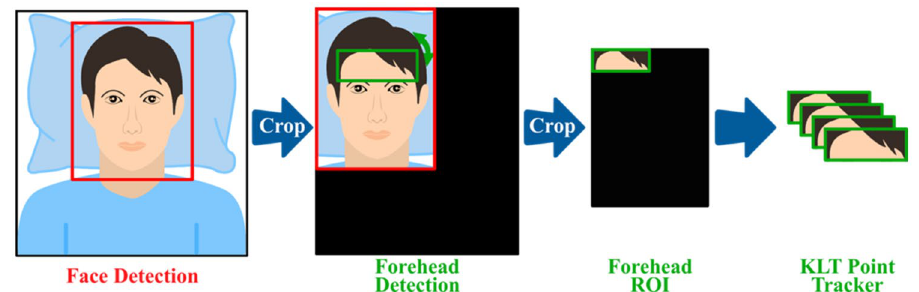
Figure 3. Face and forehead ROI tracking.